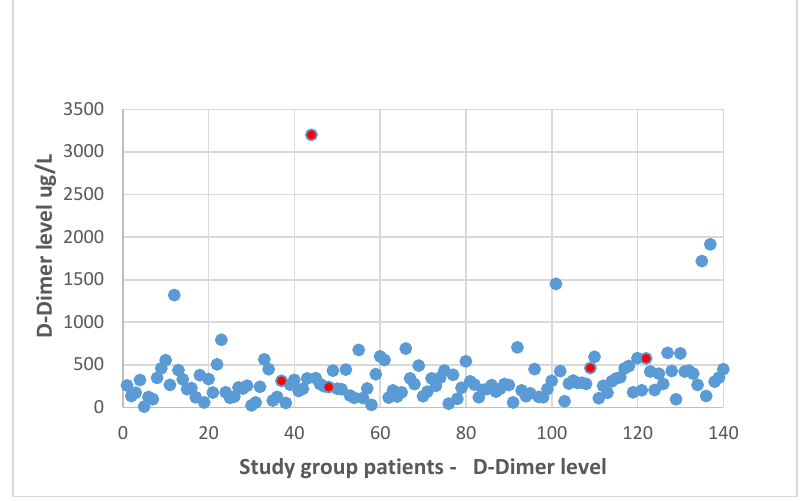
Figure 2. Preoperative D-dimer levels in the whole study group (the levels in five patients with confirmed DVT marked).